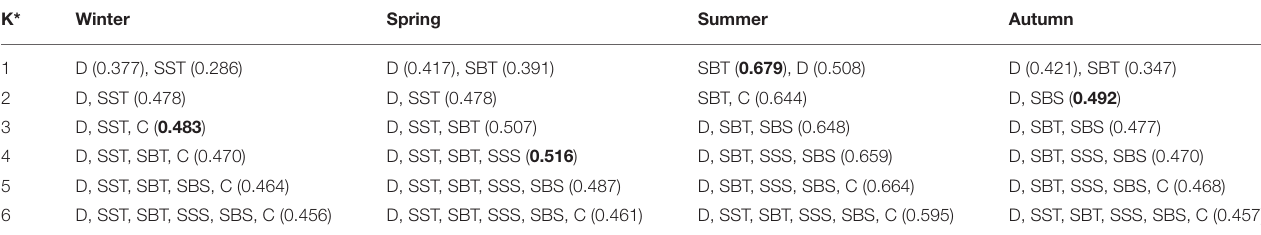
TABLE 5 | BIO-ENV analysis of zooplankton community structure in the Yellow Sea during four seasons to depth (D), sea surface temperature (SST), sea bottom temperature (SBT), sea surface salinity (SSS), sea bottom salinity (SBS) and average water column chlorophyll a concentration (C). K* Winter Spring Summer